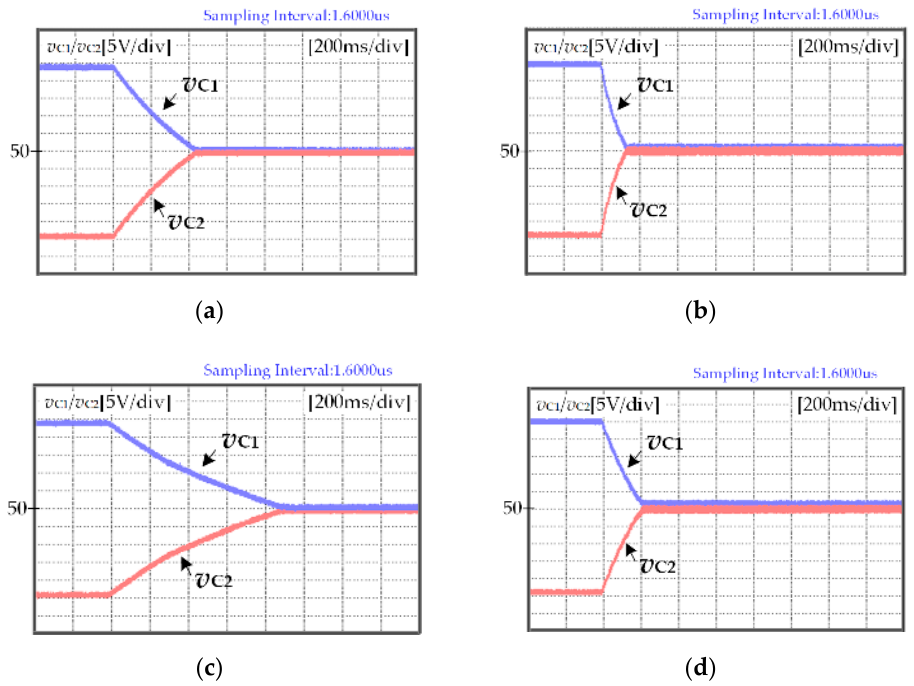
Figure 16. Capacitor voltage waveforms during the transition of the NPV balance control. ( a ) m = 0.3, cos θ = 0.954; ( b ) m = 0.8, cos θ = 0.954; ( c ) m = 0.3, cos θ = 0.732; ( d ) m = 0.3, cos θ = 0.732.